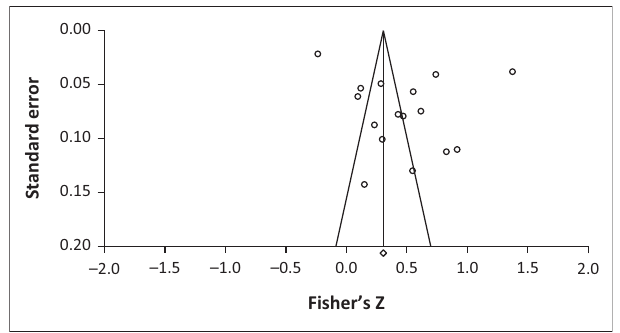
FIGURE 3: Funnel plot depicting publication bias for the association between human resource management and market performance.